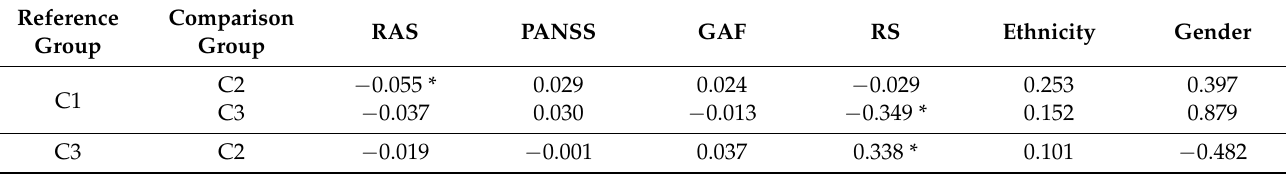
Table 5. Results of covariate analysis as predictors of latent